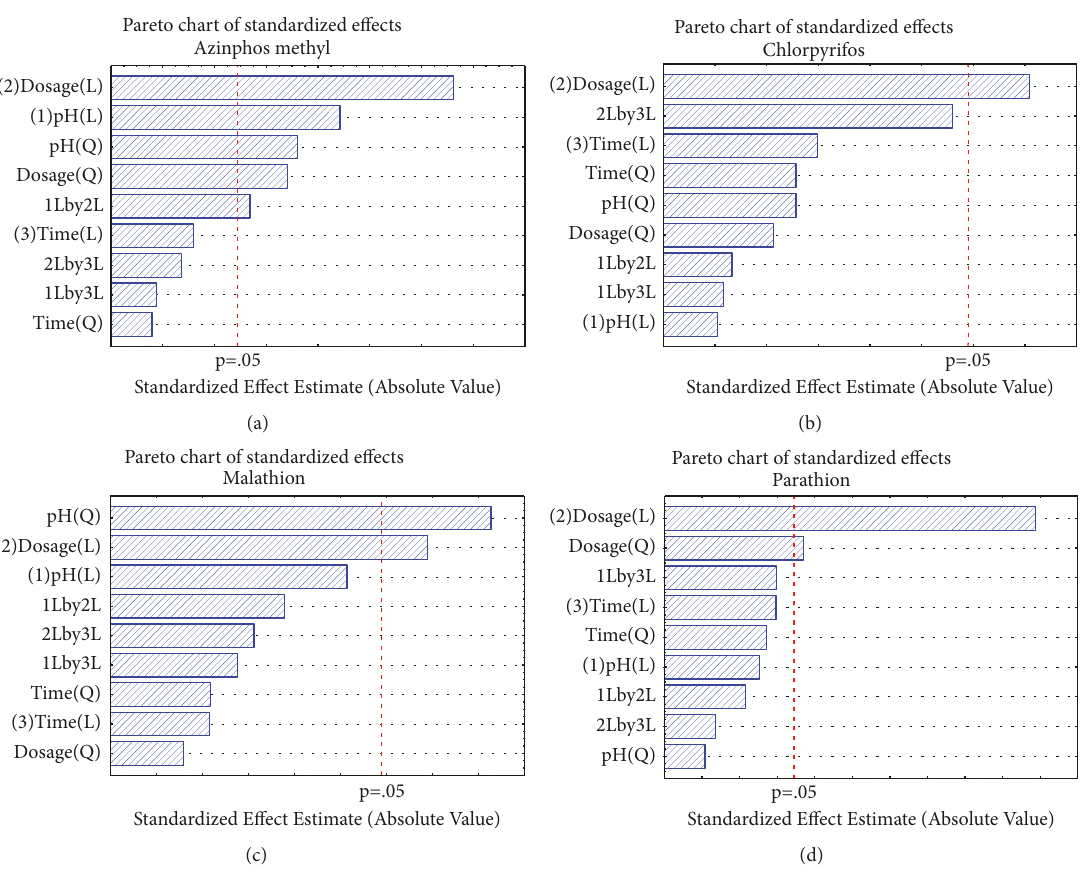
Figure 4: Pareto chart of standardized effects showing the p-value of azinphos methyl (a), chlorpyrifos (b), malathion (c), and parathion (d).